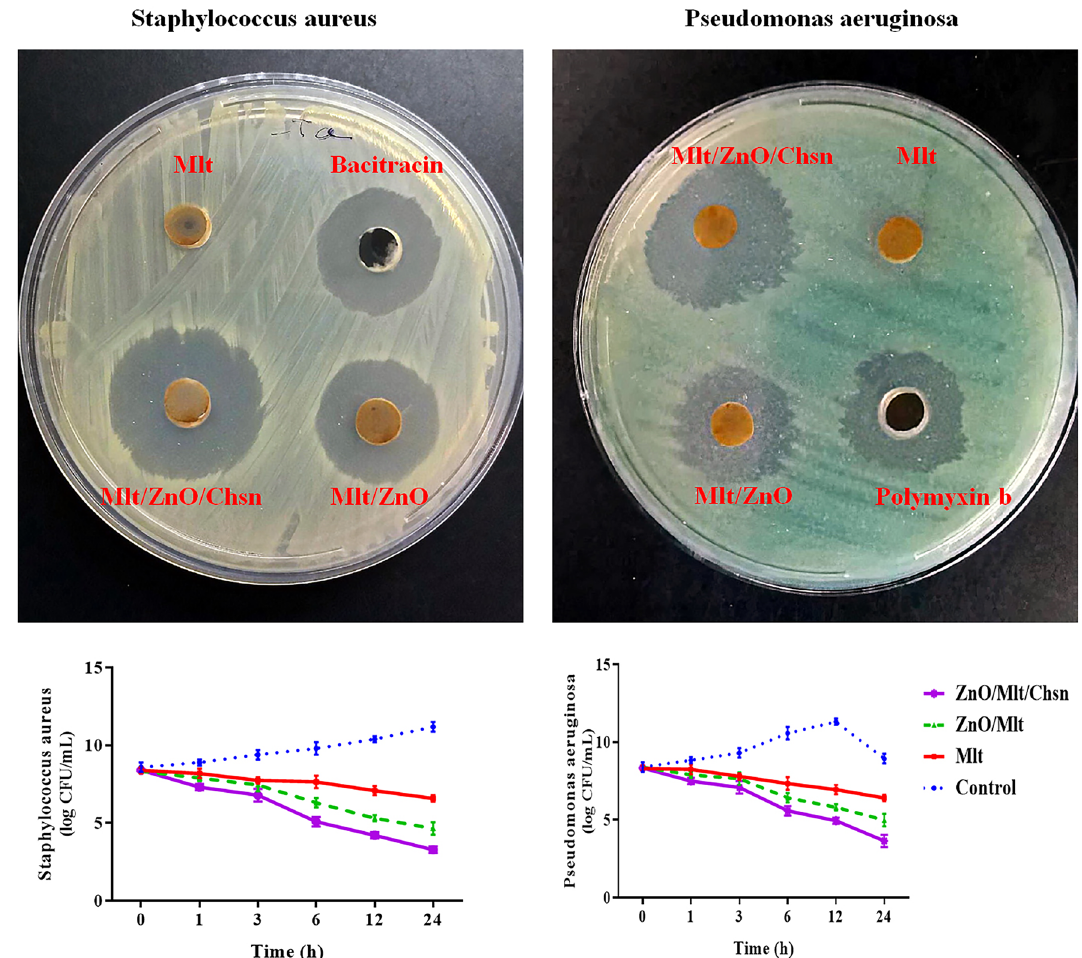
Figure 6. Antibacterial activity of Mlt, ZnO/Mlt-NC and ZnO/Mlt/Chsn-NC nanocomposites against S. aureus and P. aeruginosa in the well test. The charts show the kinetic of the antibacterial activity of experimental nanocomposites on P. aeruginosa and S. aureus and.